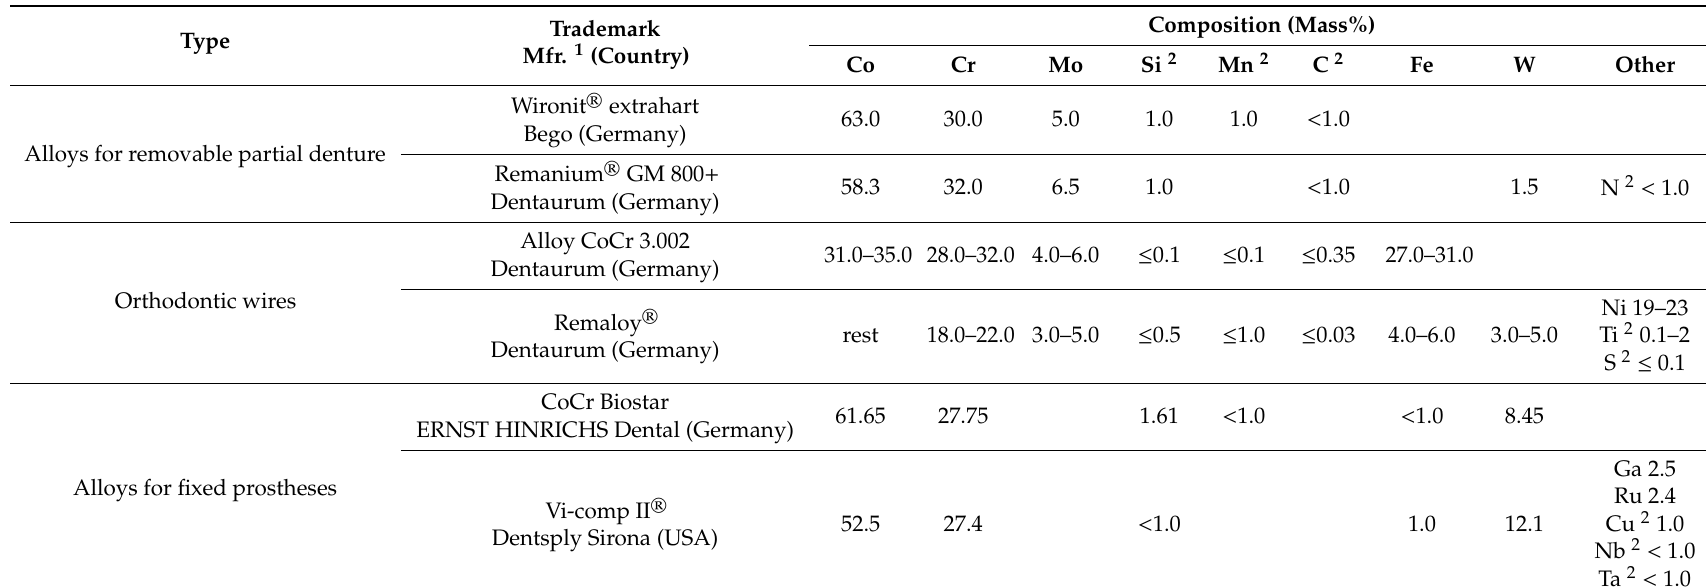
Table 1. Composition of some alloys used in